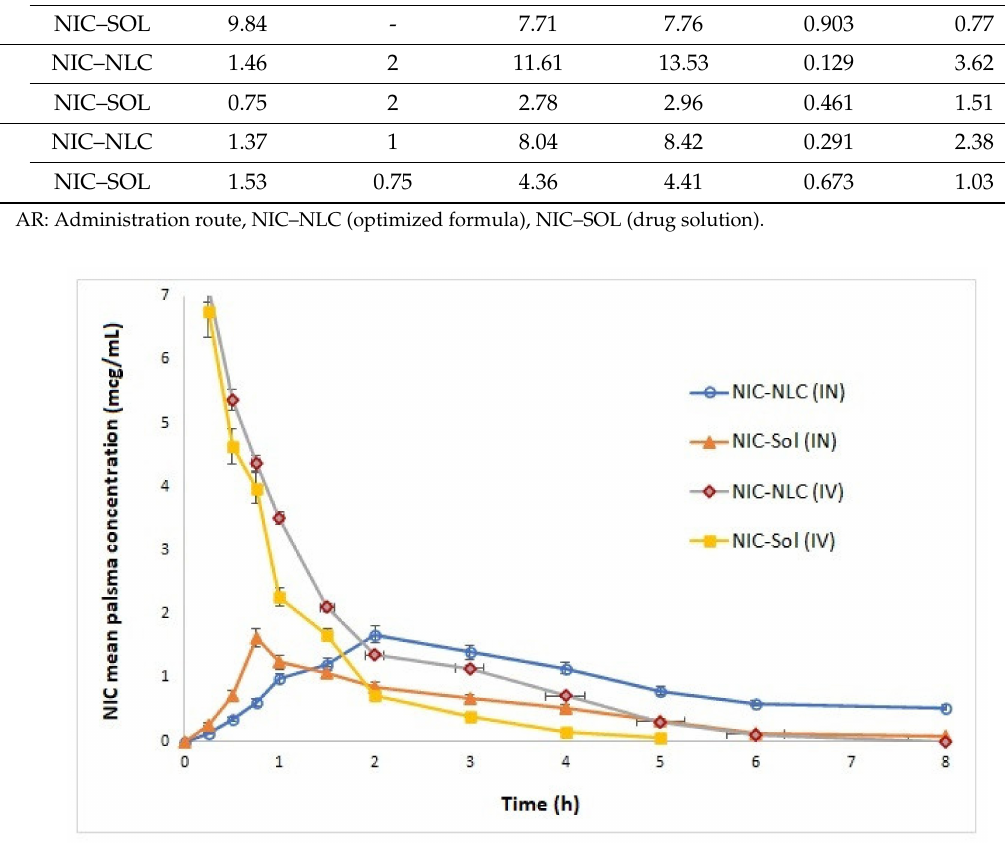
Figure 8. Mean plasma concentration–time profiles of optimized NIC–NLC compared to NIC–SOL following IN and IV administrations to Wister